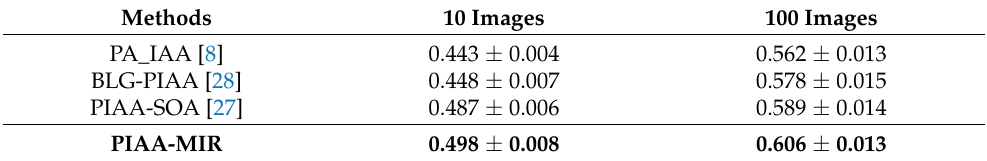
Table 3. SROCC results of our PIAA-MIR with three PIAA methods on the REAL-CUR database [22].